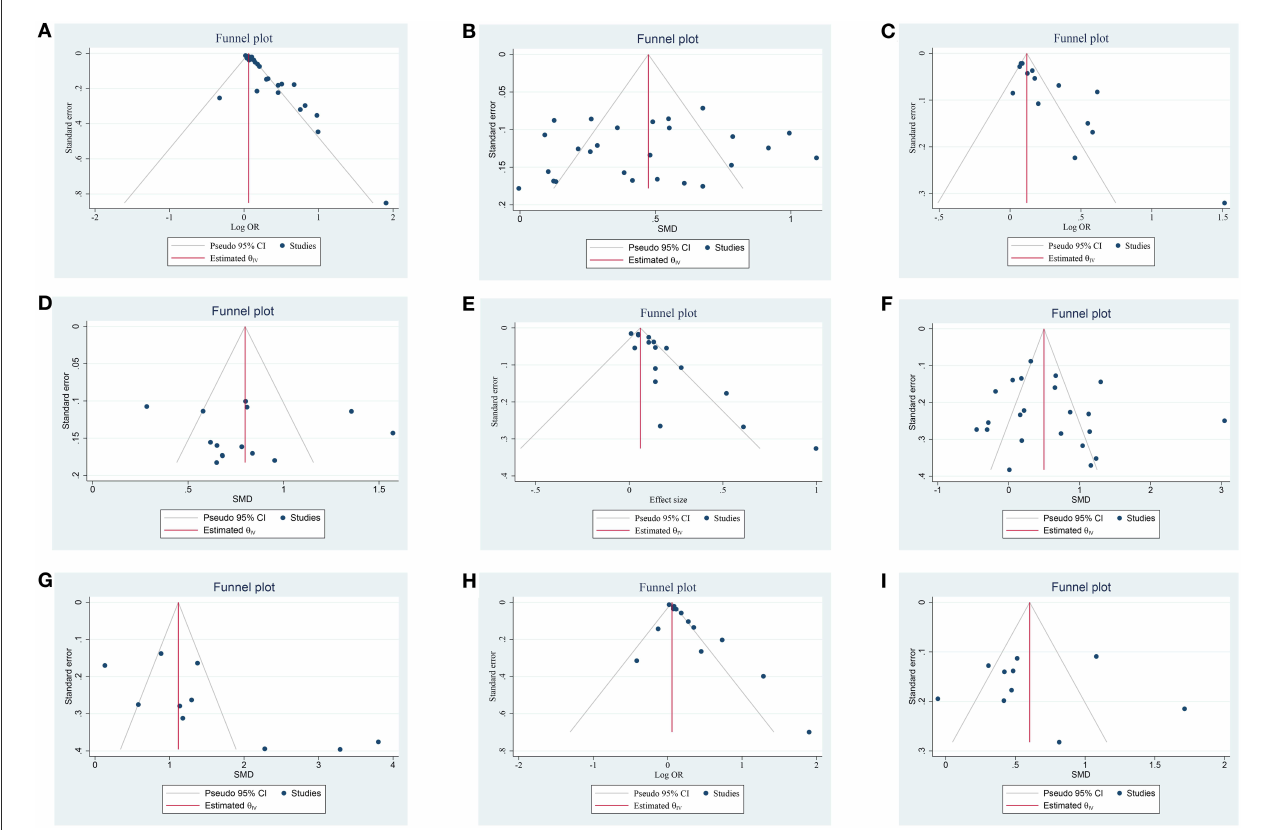
FIGURE5 Funnel plot of the publication bias on the association of NLR and prognosis; (A) funnel plot of admission NLR and 3-month PFO based on OR; (B) funnel plot of admission NLR and 3-month PFO based on SMD; (C) funnel plot of post-treatment NLR and 3-month PFO based on OR; (D) funnel plot of post-treatment NLR and 3-month PFO based on SMD; (E) funnel plot of admission NLR and sICH based on OR, (F) funnel plot of admission NLR and sICH based on SMD; (G) funnel plot of post-treatment NLR and sICH based on SMD; (H) funnel plot of admission NLR and 3-month mortality based on OR; and (I) funnel plot of admission NLR and 3-month mortality based on